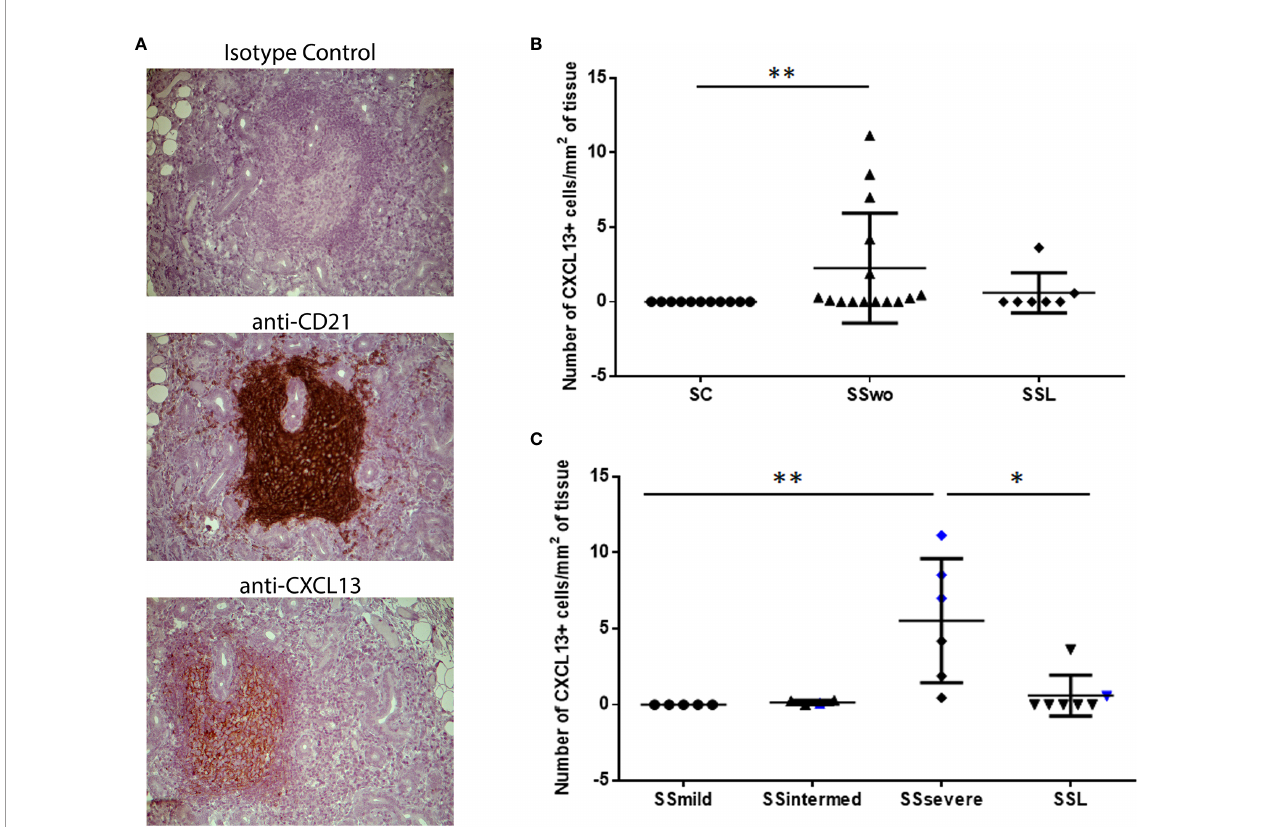
FIGURE 1 | Levels of CXCL13 expression in the MSG tissues of pSS patients and sicca-complaining controls. (A) CXCL13+-cells are detected in areas of CD21+- FDC networks in the MSG tissues of pSS patients. Representative pictures of immunohistochemical staining with isotype antibody (negative control), anti-CD21 (CD21) and anti-CXCL13 (CXCL13) antibody in MSG sections from a pSS patient with severe in fi ltrates and germinal center formation are shown. Original magni fi cation: x20. (B) Dot plot displaying the number of CXCL13+-cells per tissue area (mm 2 ) in the MSG tissues of sicca-complaining controls (SC), pSS patients without evidence of NHL (SS) and pSS patients with NHL (SSL). (C) Dot plot displaying the number of CXCL13+-cells per tissue area (mm 2 ) in the MSG tissues of the various subgroups of pSS patients without evidence of NHL, as classi fi ed according to lesion severity to those with mild (SSmild), intermediate (SSintermediate) and severe (SSsevere) in fi ltrates, as well as pSS patients with NHL (SSL). Counts in MSG tissues with ectopic germinal centers (eGCs) are designated by blue color. Comparisons in (B, C) were performed by the non-parametric Kruskal-Wallis test. P-values are designated by asterisks (*p < 0.05, **p < 0.01), whereas horizontal bars represent the mean value of the group. Only statistically signi fi cant associations are